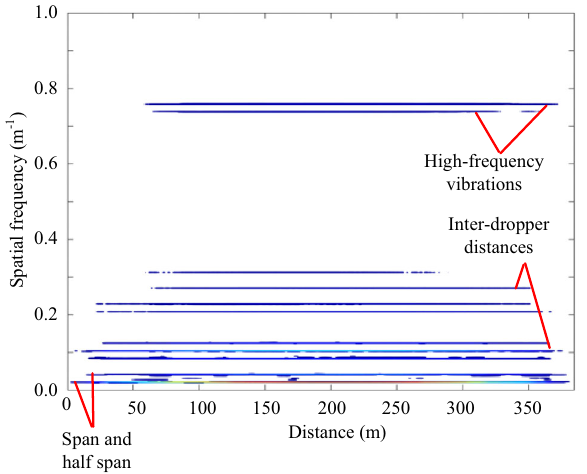
Span and half span Fig. 16 Time–frequency analysis of the pantograph–catenary contact